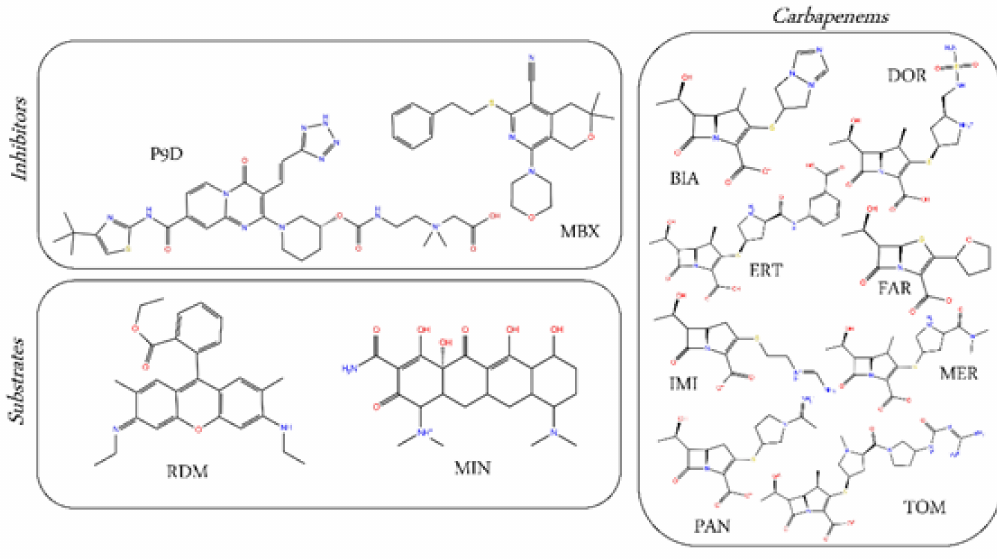
Figure 2. Two-dimensional (2-D) structures of the substrates / inhibitors co-crystallized with AcrB and of the selected carbapenems antibiotics considered in this